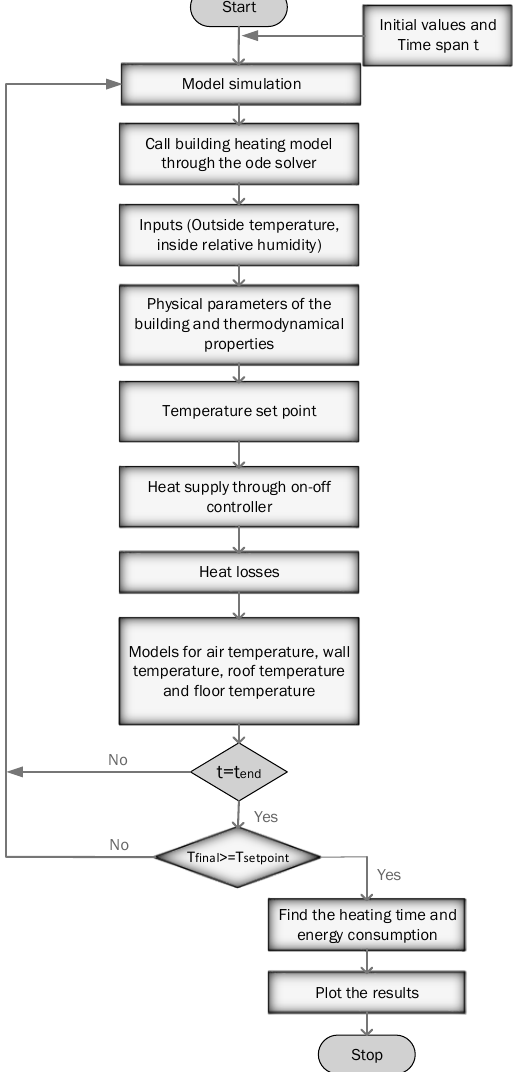
Figure 4. Algorithm for calculating the heating time and the energy consumption. This is implemented using the MATLAB ode23s